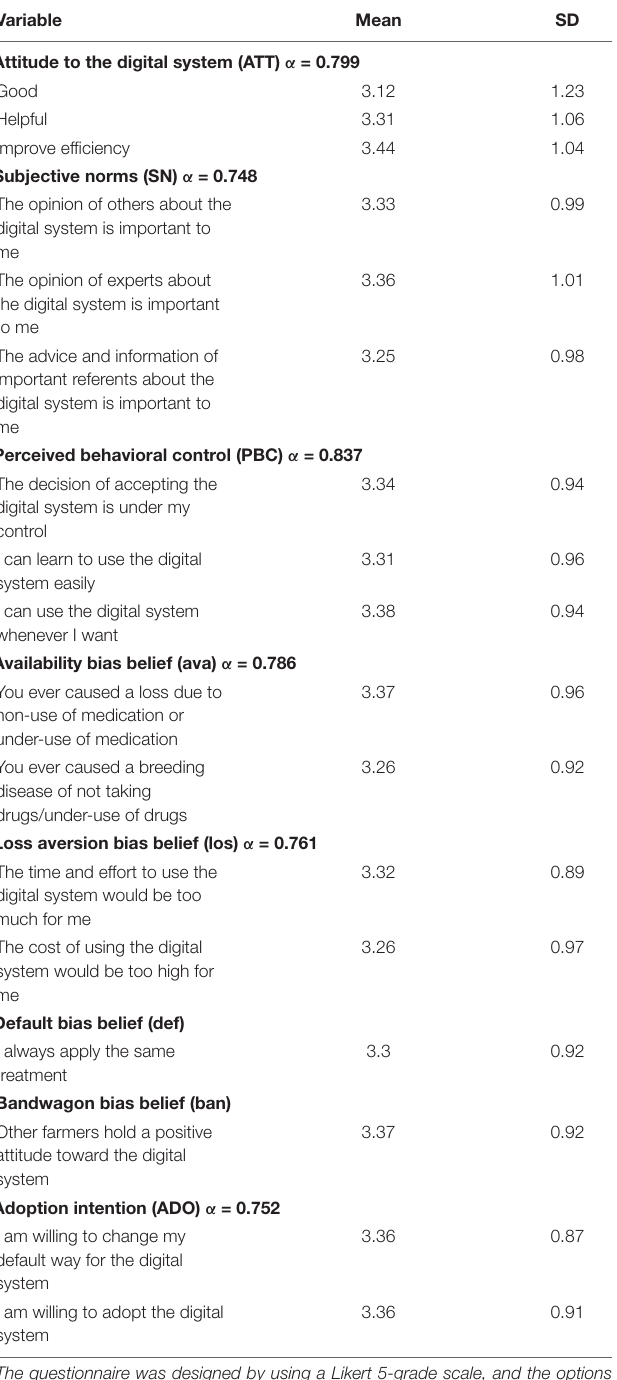
TABLE 2 | Descriptive statistics of key variable indicators.